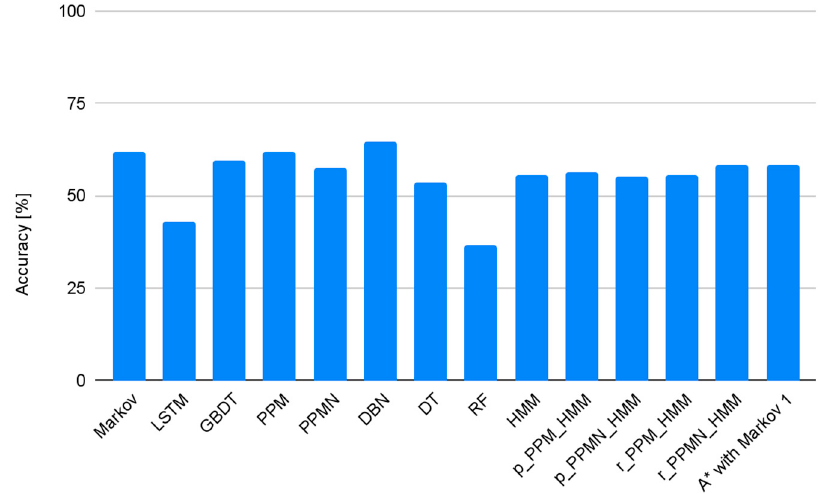
Figure 11. Coverage on the students’ dataset.